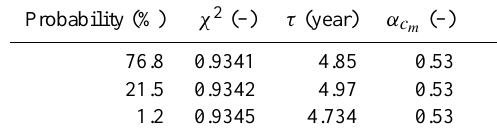
Table 2. Red Flag output for the Time Decay model.